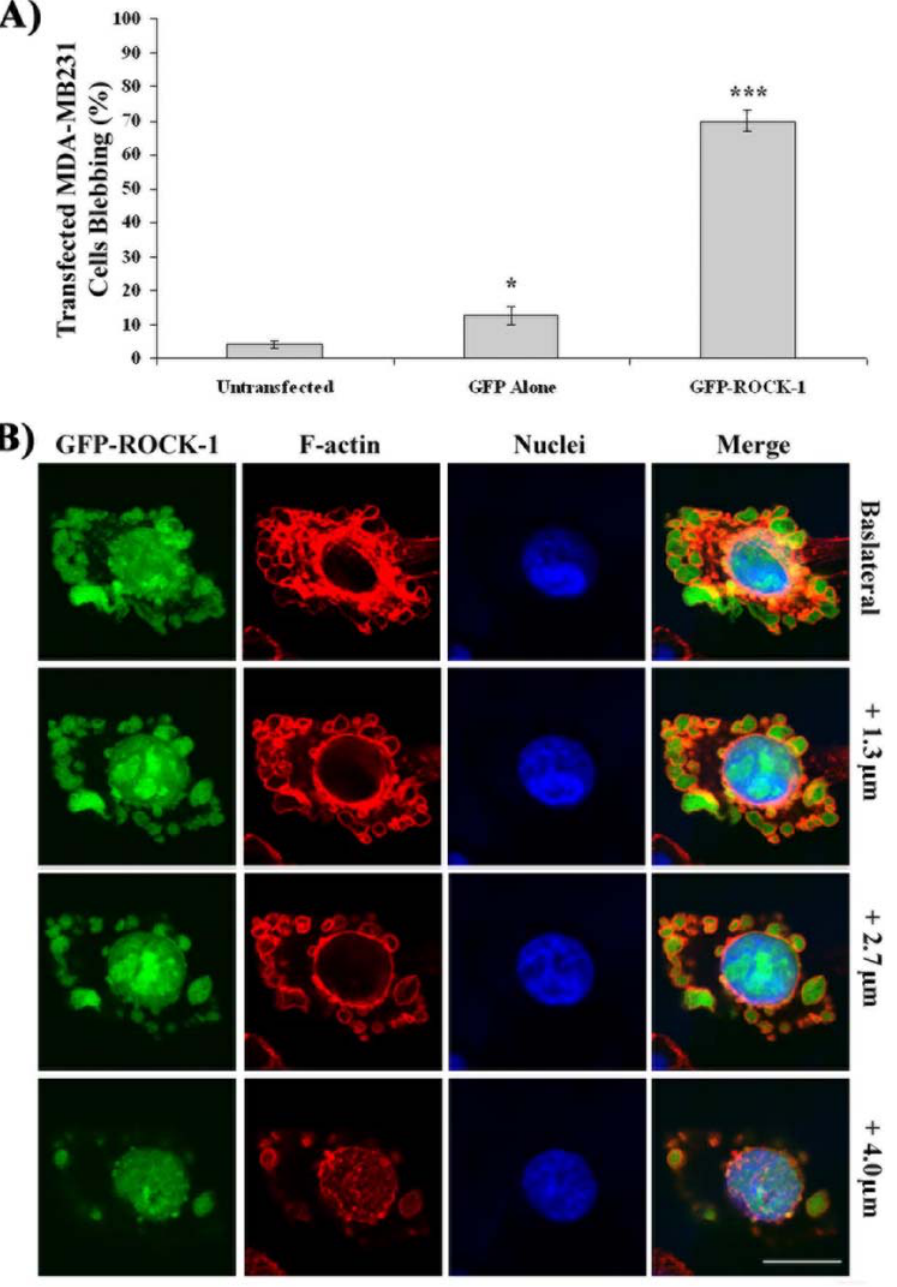
Figure 2. ROCK1 but not LIMK2 induces blebbing. A) MDA-MB231 cells were transfected with GFP-ROCK1 or GFP-LIMK2, fixed and stained with Alexa Fluor 594-Phalloidin and Dapi. 150 cells over 3 independent experiments were scored for visible blebbing + / 2 s.e.m. P , 0.05; ***P , 0.001. B) Representative images from varying optical slices of a blebbing cell overexpressing GFP-ROCK1. (Bar=20 m m).